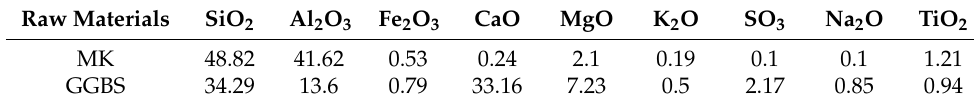
Table 1. Chemical compositions of the raw materials (Wt.%).